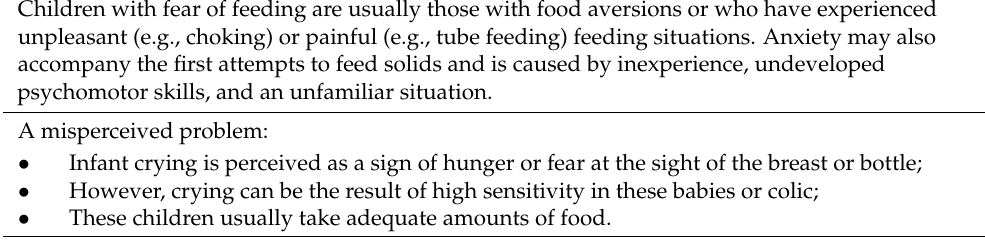
Table 2. Classification of feeding difficulties according to Kerzner et al. in terms of fear of food/feeding (own elaboration) [22]. Fear of